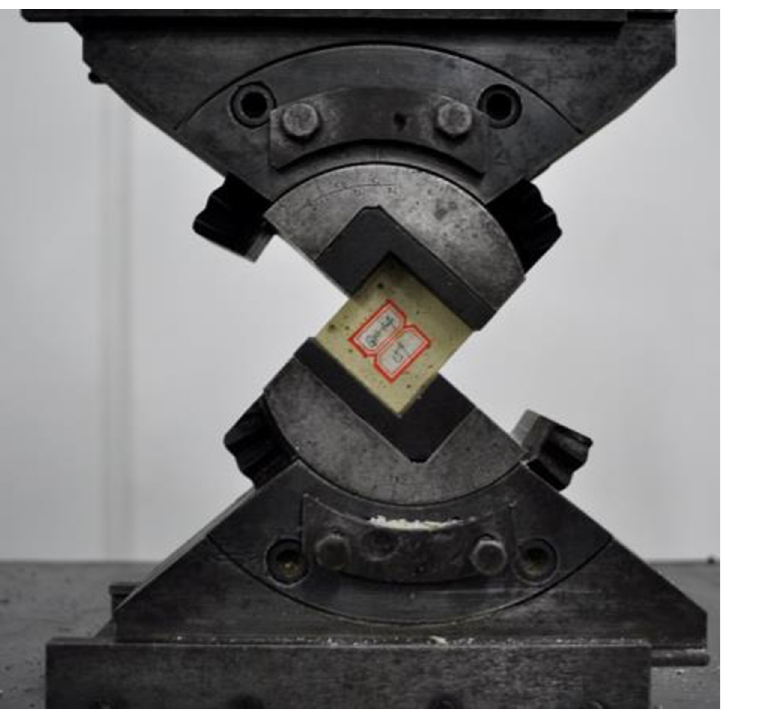
Fig 13. Direct shear